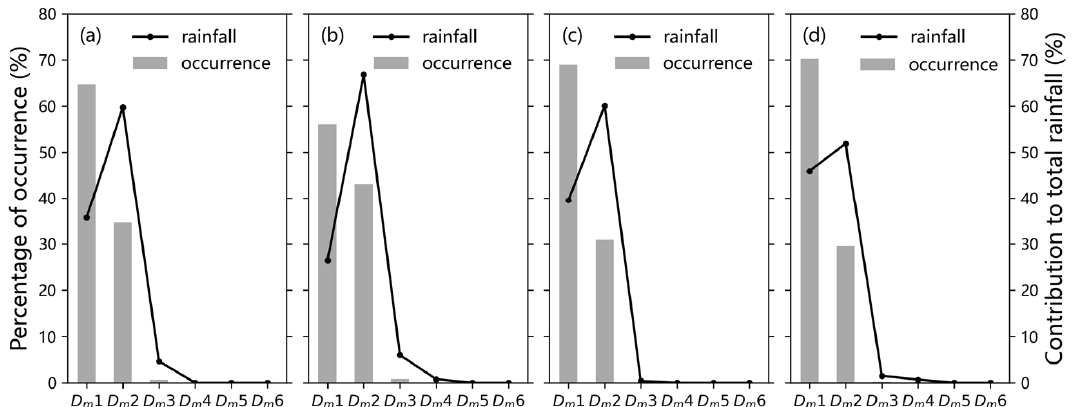
Figure 6. Percentages of occurrence (bar) and relative contributions to the total rainfall (line) from the different D m bins in the four seasons: winter ( a ), premonsoon ( b ), monsoon ( c ) and postmonsoon ( d ).